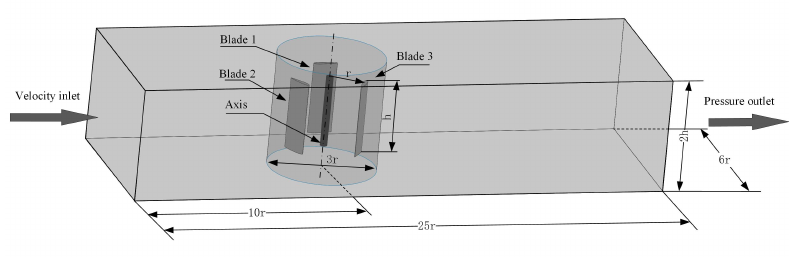
Figure 8. Three-dimensional computational domain